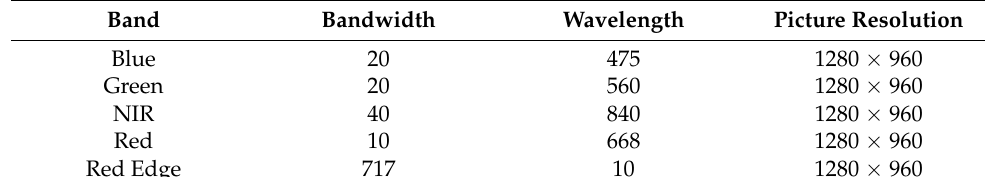
Table 3. Specifications of sensors used in the present study.